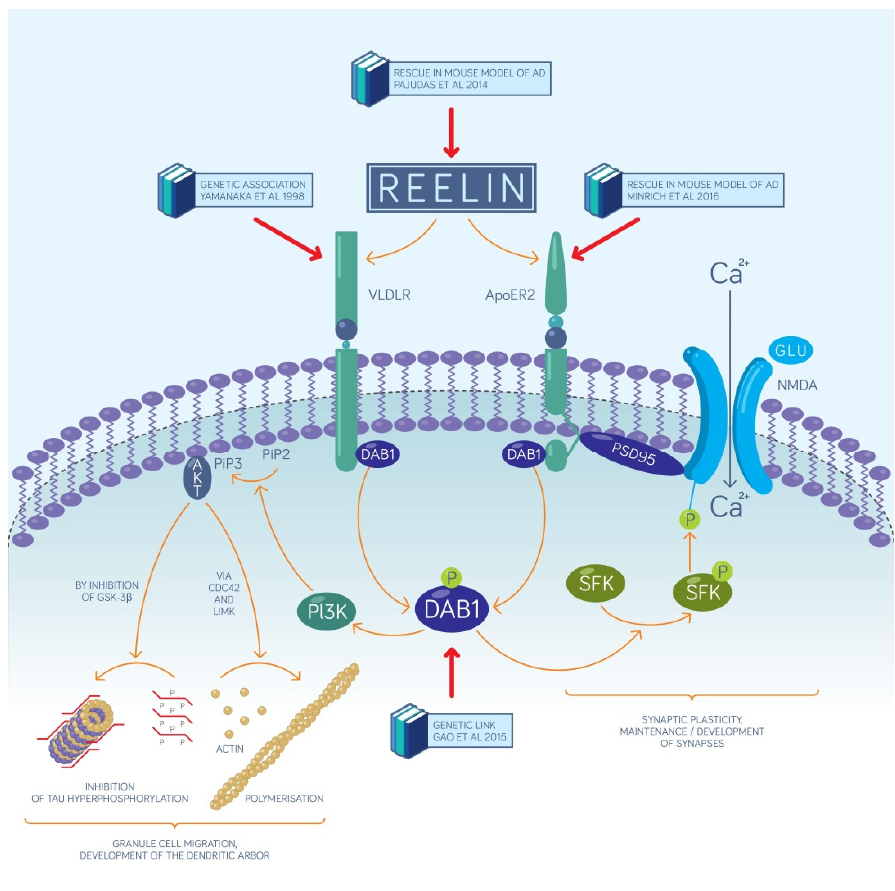
Figure 1. The key actors of reelin signaling. The two neuronal receptors of reelin are depicted in green, along with their downstream effector molecules. On the left, we show the mechanism of how the cellular migration and the dendritogeneis are promoted by reelin, while on the right the main intracellular pathway leading to synaptic plasticity and synaptogenesis is highlighted. Both mechanisms are essential for the newborn granule cells to establish functional contacts with entorhinal input axons. More than two decades of research link AD to a deficit of adult reelin signaling hence some key reports describing prominent links to particular signaling molecules are indicated and coupled to those molecules with a red arrow.